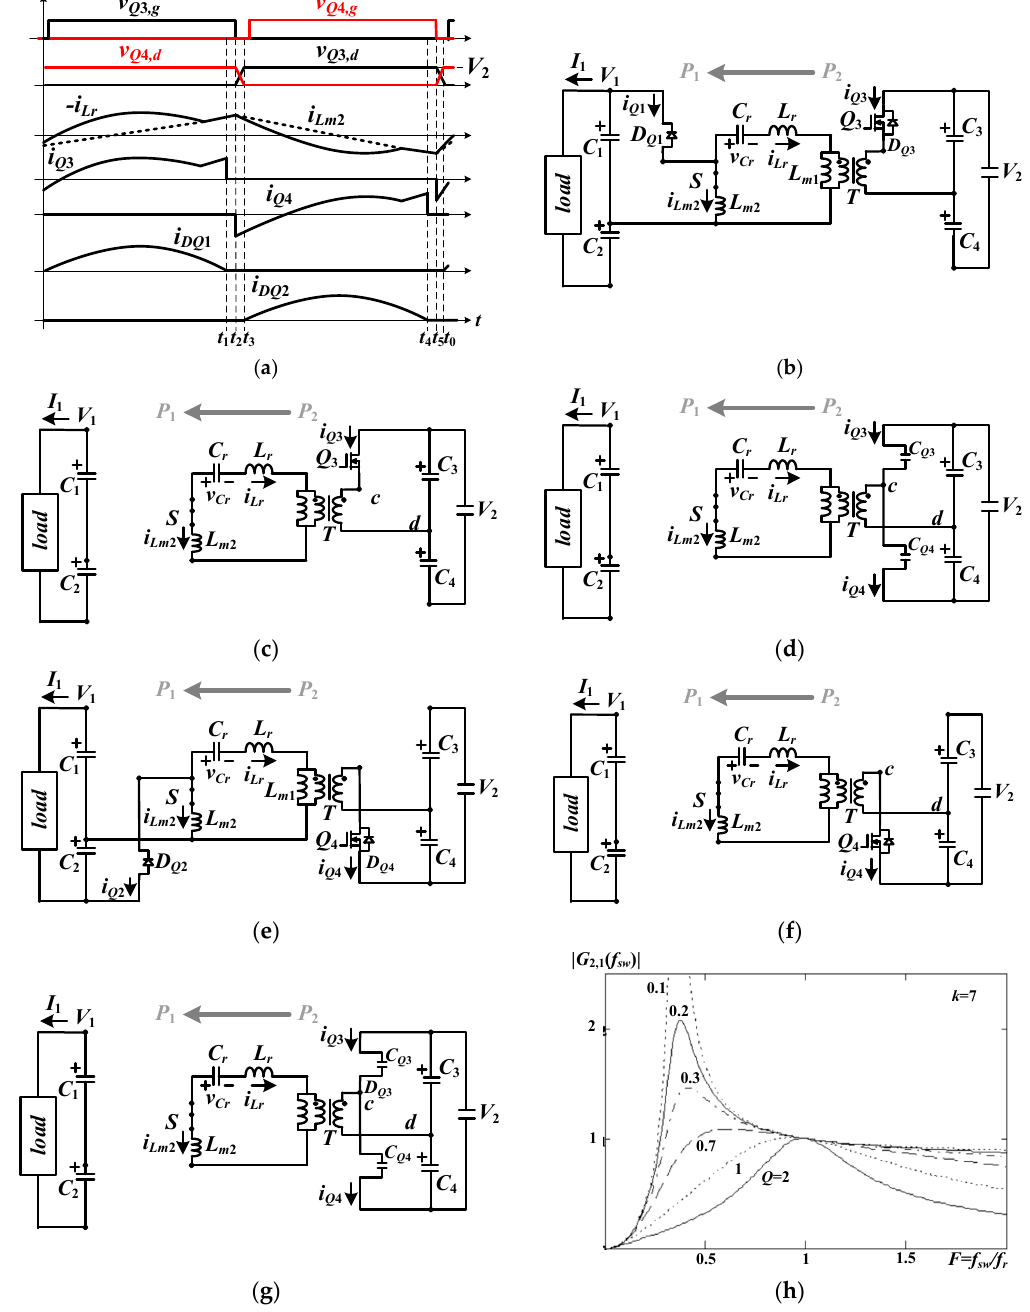
Figure 4. PWM waveforms, stage operations, and gain curve under reverse power flow: ( a ) PWM waveforms; ( b ) Stage 1; ( c ) Stage 2; ( d ) Stage 3; ( e ) Stage 4; ( f ) Stage 5; ( g ) Stage 6; ( h ) gain curve of the studied circuit.